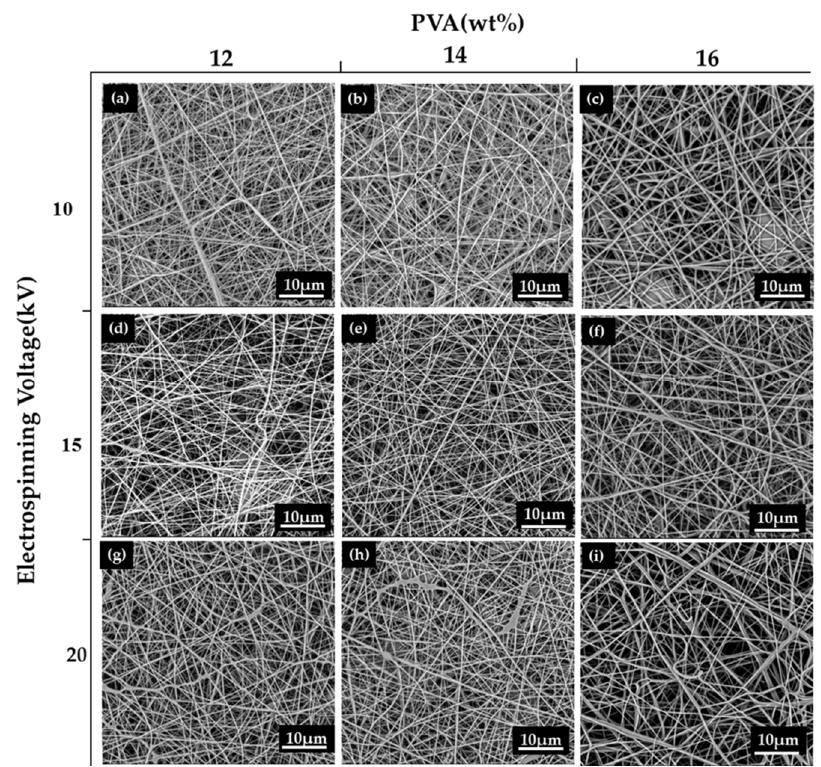
Figure 2. SEM images of PVA nanofibrous membranes with different combinations of concentration of PVA solution (column: 12, 14, and 16 wt %) and spinning voltage (row: 10, 15, and 20 kV).